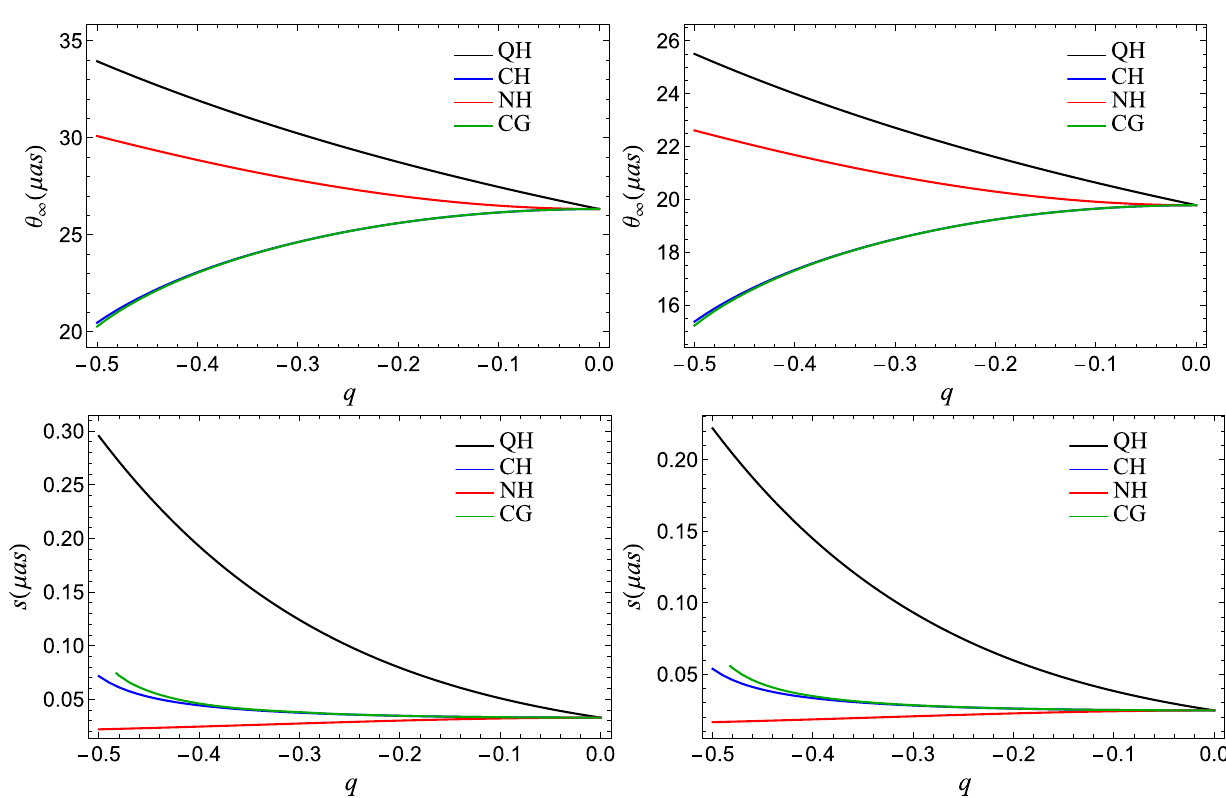
Fig. 9 The behaviour of lensing Observables θ ∞ , s for quartic Horn- deski black holes (QH), charged Horndeski black holes (CH), Horn- deski black holes (NH) and charged Galilleon black holes (CG) with q by modelling them as Sgr A* black hole (left) and M87* black hole